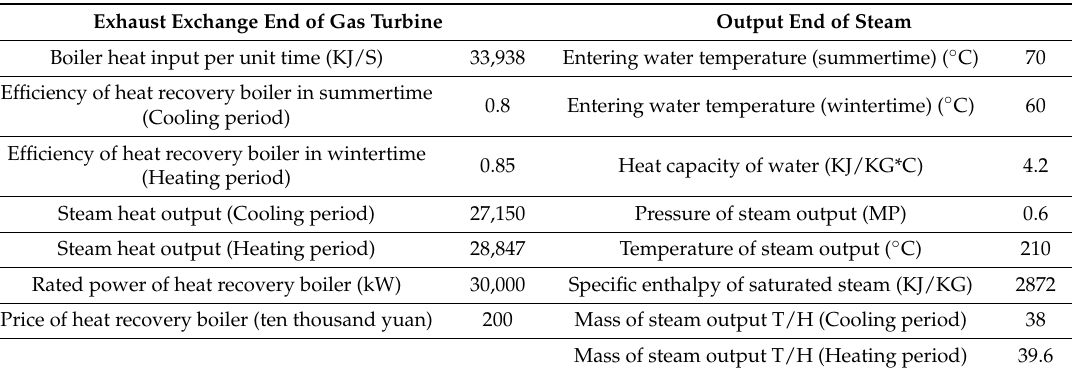
Table 3. Parameters of heat recovery